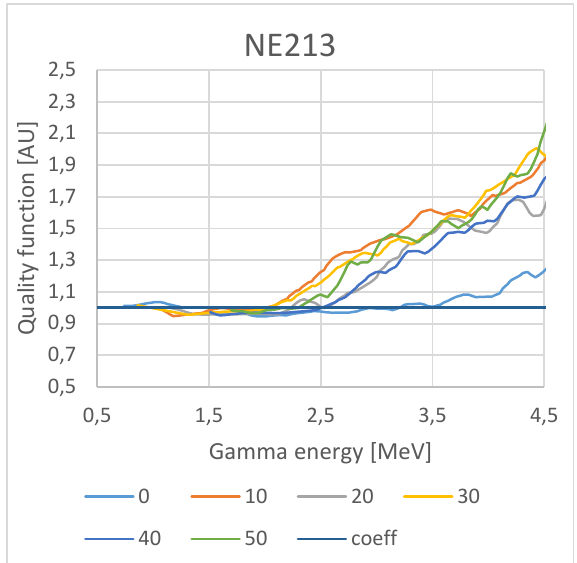
Fig. 4. FOM temperature dependencies of